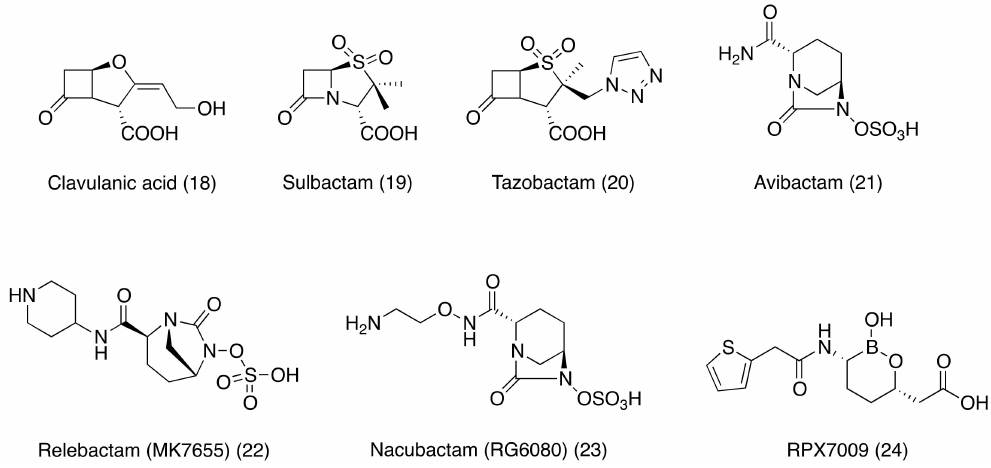
Figure 4. Chemical structures of β -lactamases inhibitors discussed in this